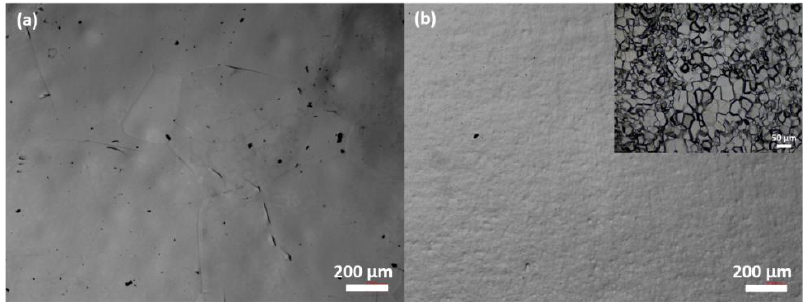
Figure 1. Optical microscope images of ( a ) untreated Ti foil; and ( b ) granulated Ti foil.